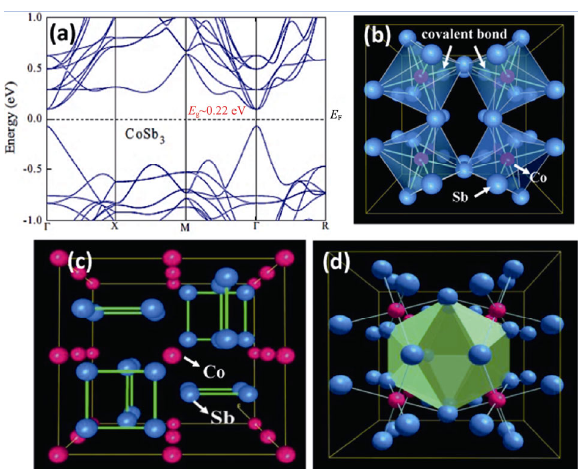
Fig. 1 (a) Band structure (reproduced with permission from Ref. [31], © American Physical Society 2008) and (b–d) crystal structure of CoSb 3